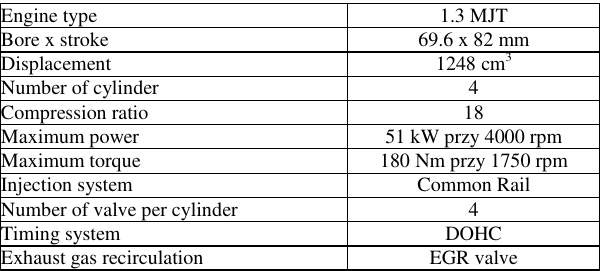
Table 1. Technical specification of Fiat 1.3 MJT engine